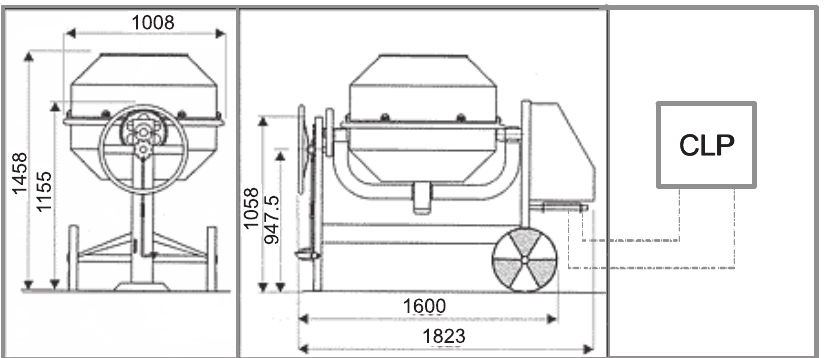
figura 1. esquema do reator utilizado na biorremediação. Clp: temporizador automático ajustado para ligar reator durante 20 min; e desligar durante 40 min, 24 h por dia, durante 120 dias de biorreme- diação. medidas em